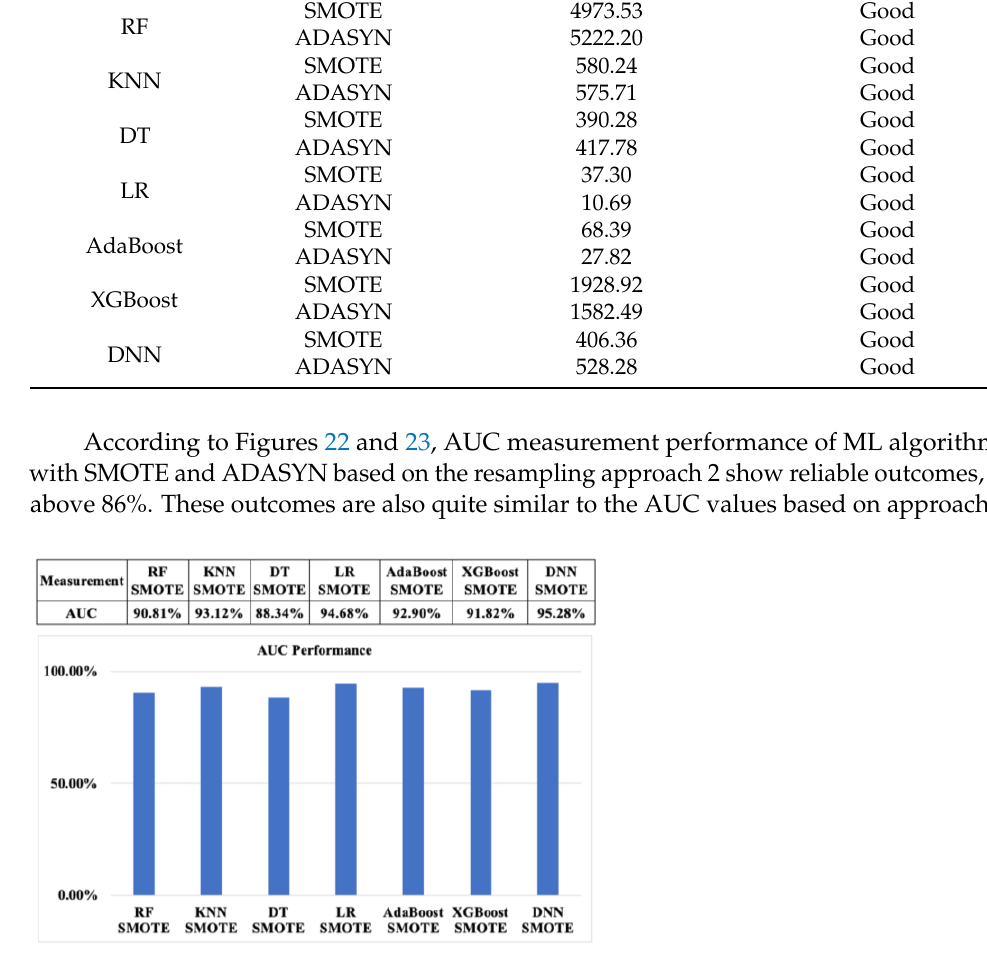
Figure 22. AUC measurement performance of machine learning algorithms with SMOTE based on resampling approach 2.